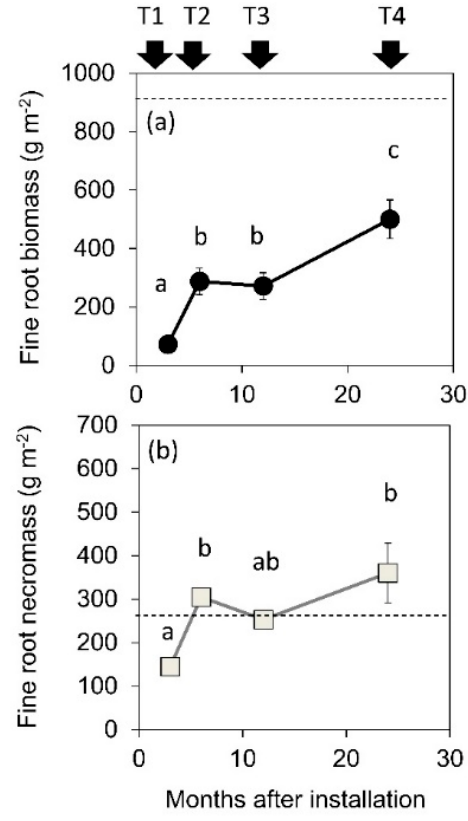
Figure 2. Temporal variation in ( a ) fine root biomass and ( b ) fine root necromass inside the cores between sampling time T1 and T4. Different letters indicate significant differences among the sampling times ( p < 0.05). Standard errors are indicated ( n = 3). Dashed lines indicate fine and dead root biomass outside the cores (968.7 ± 32.9, 288.8 ± 40.0 g m − 2 , respectively).